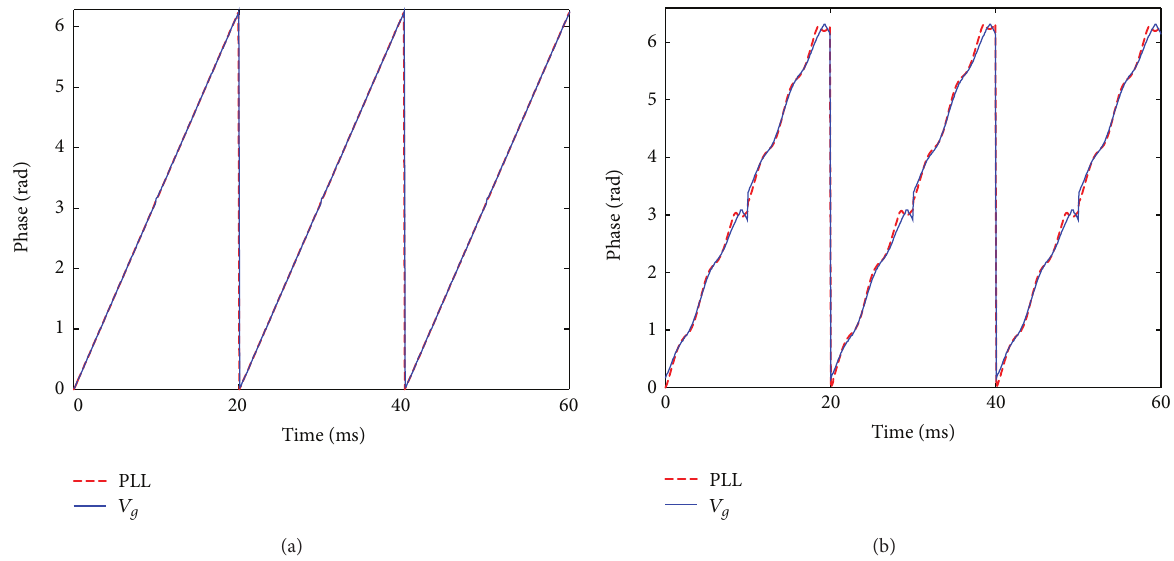
Figure 9: PLL phase tracking versus the grid phase for (a) a perfect grid and (b) a grid polluted with 5% of the 3rd, 5th, and 7th harmonics.